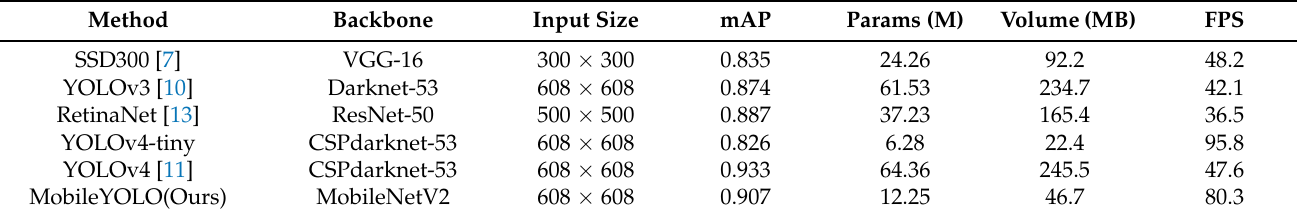
Table 4. Comparison of other algorithm